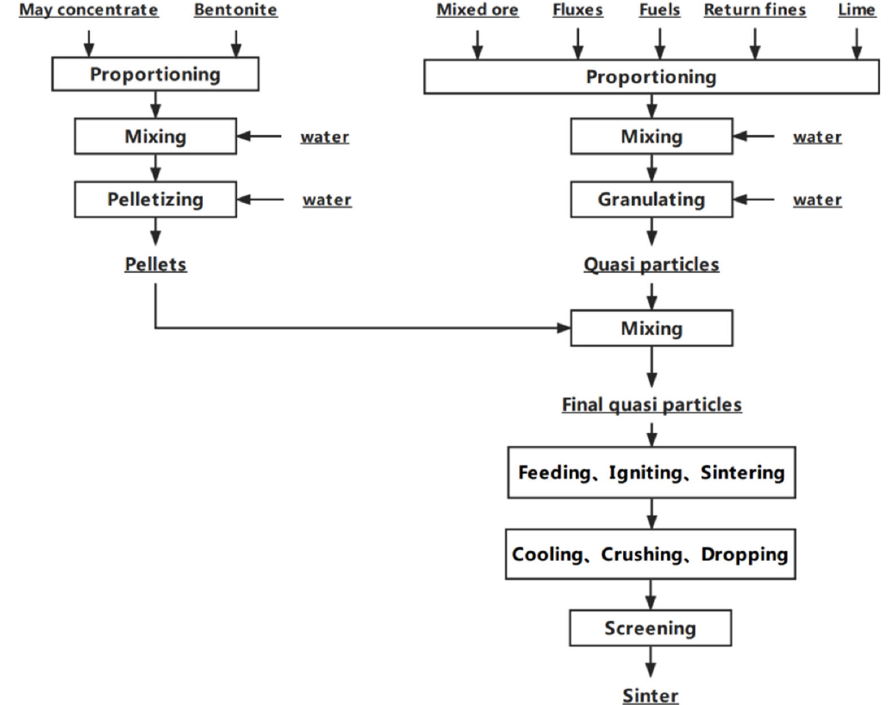
Figure 2. The process of pre-pelletizing granulation sintering.